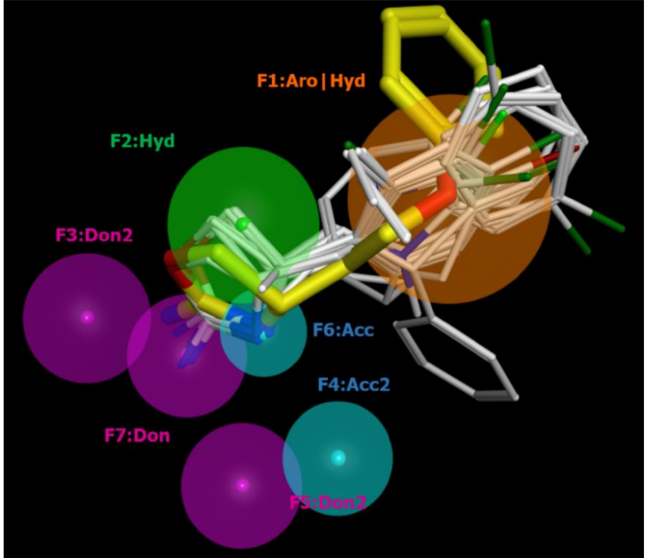
Figure 4. Alignment of the oxazolines included in the pharmacophore model generation (compounds 4b , 5b , 9b – 11b , 16b , 18b , 20b – 23b , 25b , 29b , 33b – 37b , Table S1), based on the chemical structure, as represented by the previous conformer analysis [31]. All oxazolines are shown as thin sticks, with the following atom color code: C , gray; halogen, green; N , blue; O , red). The reference compound 20b is depicted as bold sticks with the same atom color code except for C , here in yellow for better